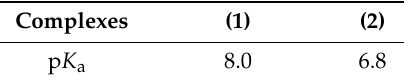
Table 1. Observed p K a of complexes ( 1 ) and ( 2